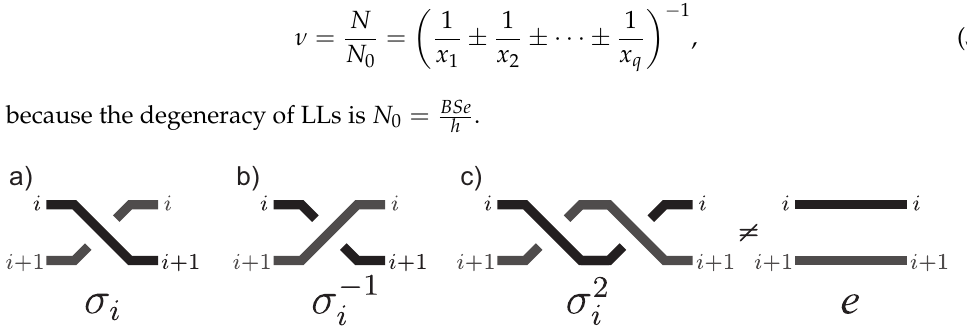
Figure 3. ( a ) Conventional geometric presentation for the generator σ i of the full braid group [34,35]— this generator describes the transposition of a particle i -th with ( i + 1 ) -th one on the plane R 2 when other particles remain on their positions. ( b ) Inverse braid σ − 1 M = R 2 is not a neutral element of the group (though for M = R 3 , σ 2 simplicity of the braid group in 3D in comparison to 2D